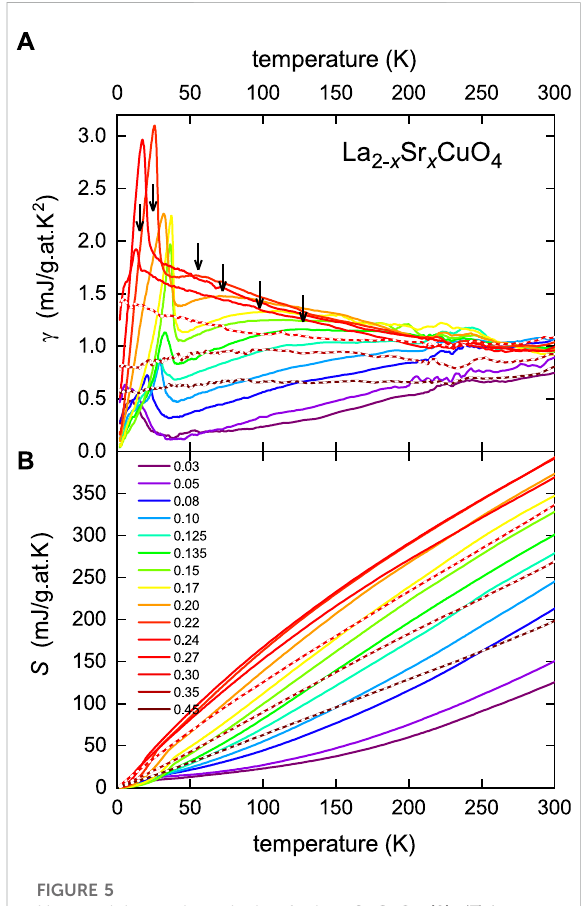
FIGURE 5 Measured thermodynamic data for La 2 − x Sr x CuO 4 . (A) γ ( T ) for x ranging from 0.03 to 0.45 (see color-coded legend). Curves for x = 0.30, 0.35, and 0.45 are dashed for ease of identi fi cation. The peaks associated with the proximate van Hove singularity are indicated by arrows. (B) The electronic entropy, S ( T ). Data partly from [11].